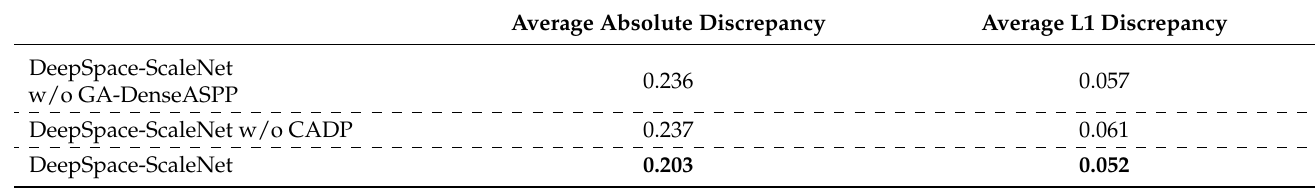
Table 4. Ablation experiment on different components of DeepSpace-ScaleNet. Average Absolute